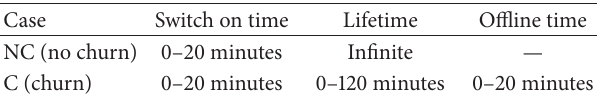
Table2:ParametersoftheperformanceevaluationcasesinScenario II.